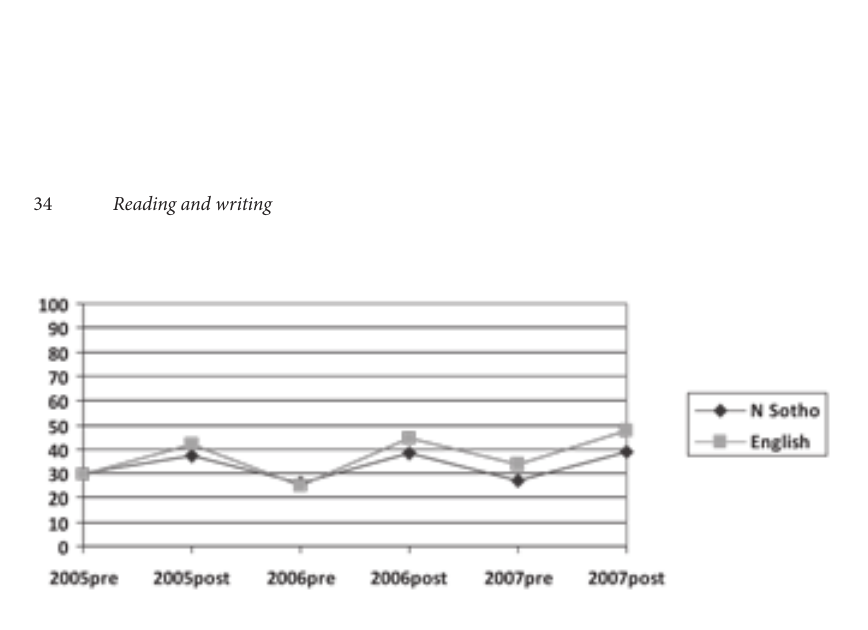
Figure 2: N Sotho and English reading Comprehension – pre and post-test results